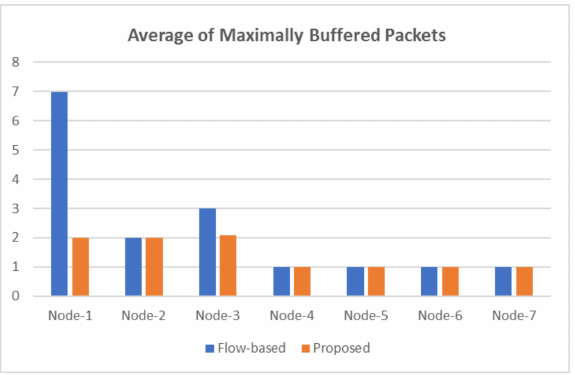
Figure 7. Average number of maximally buffered packets of each node in the proposed algorithm and the flow-based